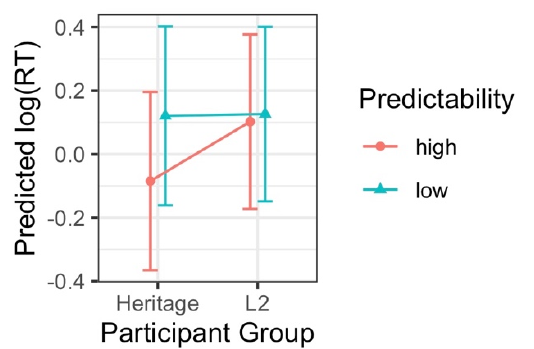
Figure 3. Estimated marginal means from the fitted RT model depicting the interaction between Predictability and Group, with other effects held constant.